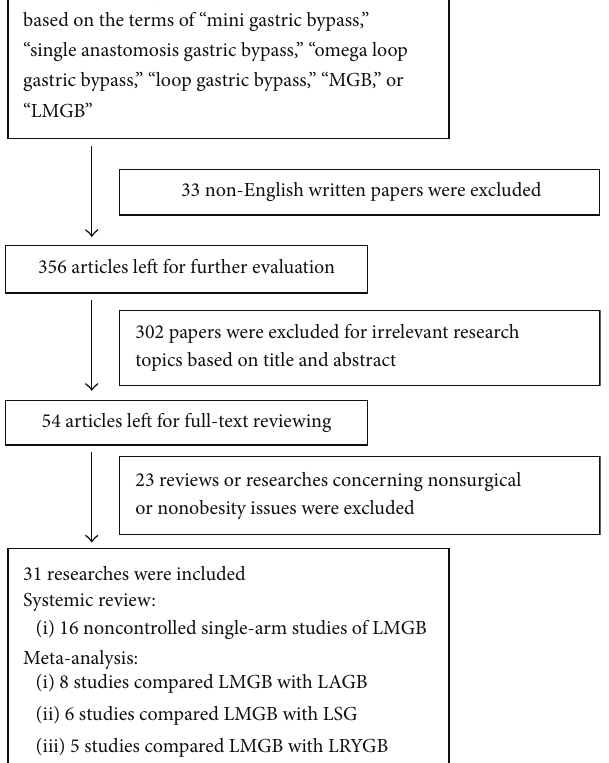
most studies. The percentages of patients with T2DM varied from 0 to